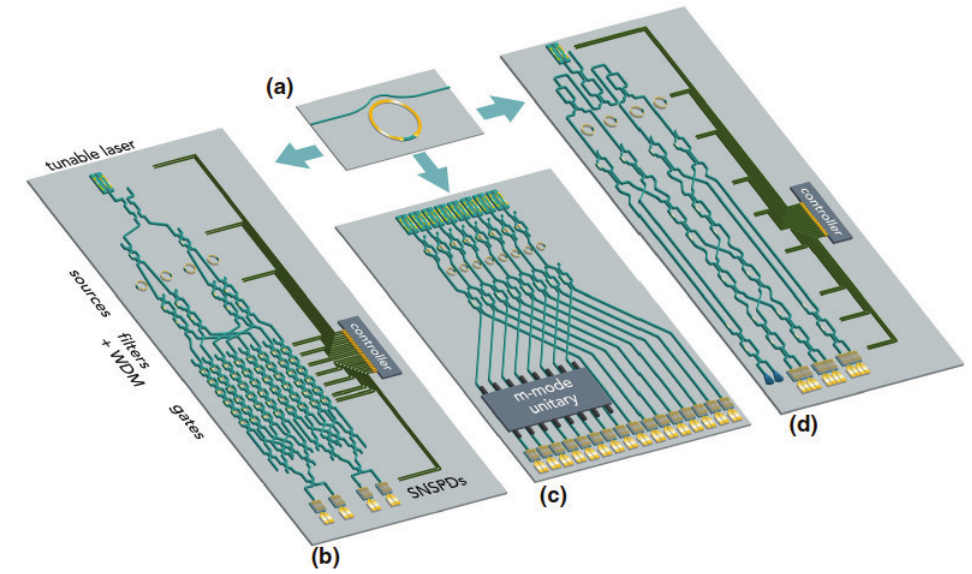
Figure 17. ( a ) Tunable AlGaAs-OI MRR entangled-photon-pair source. AlGaAs-OI represents a practical host platform for a monolithic integration of the source with ( b ) quantum gates for optical computers, ( c ) m -mode unitary operations for boson sampling, and ( d ) Bell-state measurements for chip-to-chip quantum-state teleportation. The figure is reprinted from